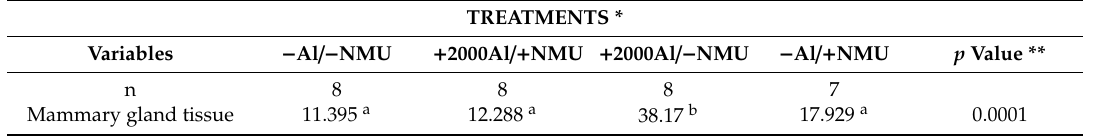
Table 1. Concentration of aluminum (median of µ g Al / g of tissue) in the mammary gland of